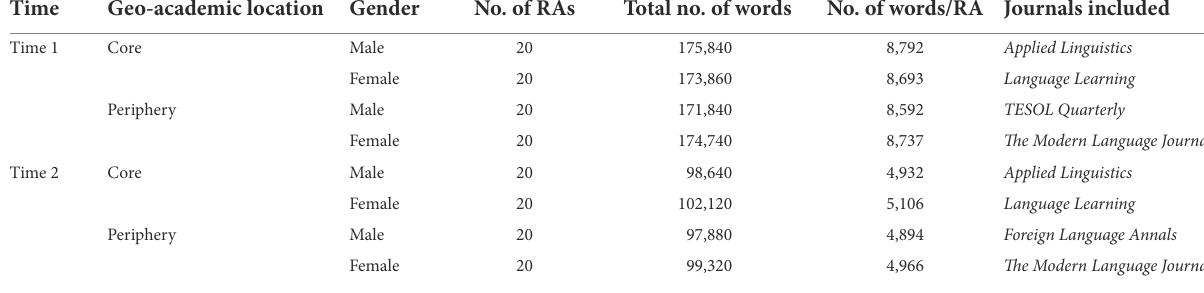
TABLE 1 Profile of the corpus.